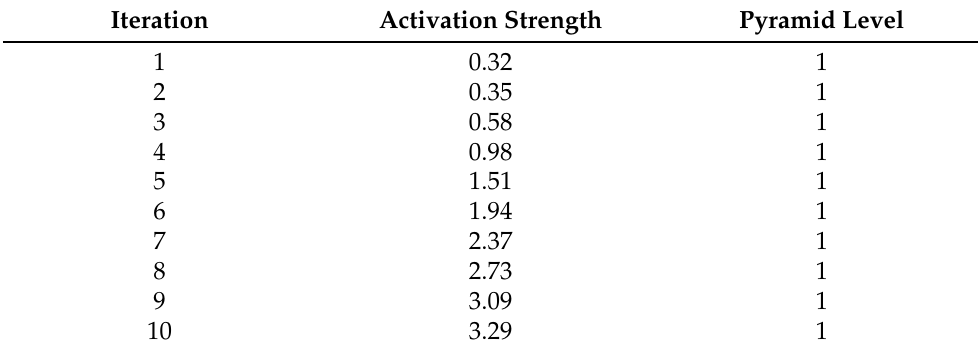
Table 4. Activation strength of 56 features learned by the average pooling layer for Inception-V3.